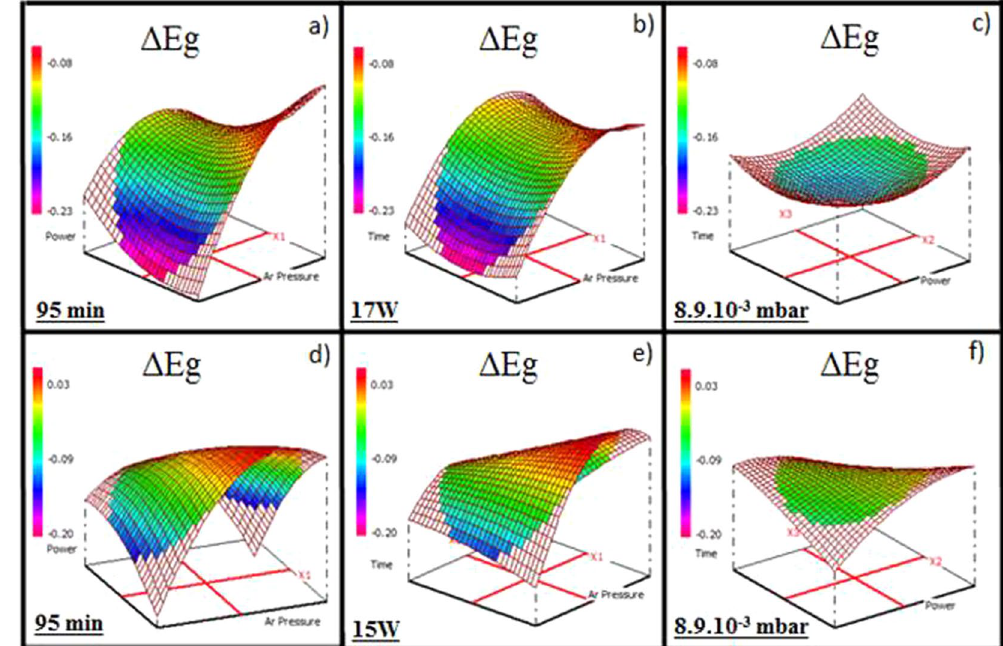
Figure 5. Variation of Δ E g of the Ge 28.1 Sb 6.3 Se 65.6 thin films for ( a ) a fixed deposition time of 95 min, ( b ) a fixed working power of 17 W, ( c ) a fixed Ar pressure of 8.9.10 − 3 mbar and the Ge 12.5 Sb 25 Se 62.5 thin films for ( d ) a fixed deposition time of 95 min, ( e ) a fixed working power of 15 W, ( f ) a fixed Ar pressure of 8.9.10 − 3